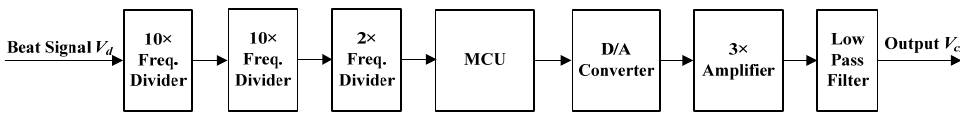
Figure 2. Block diagram of the frequency discrimination and control module (FDCM).